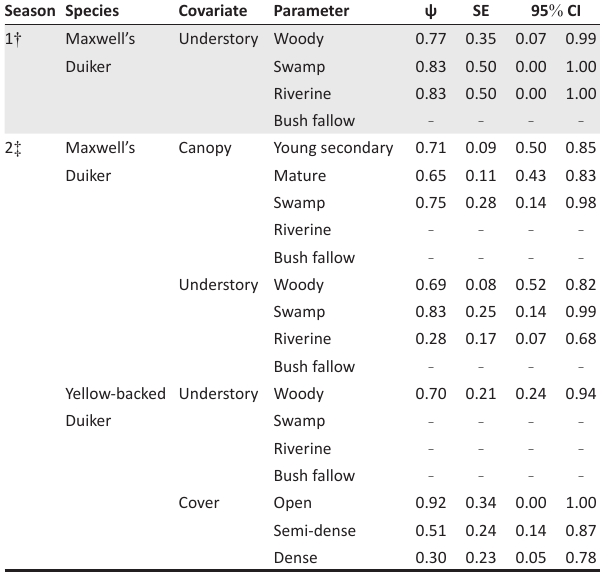
TABLE 3: Duiker occupancy of specific Tiwai Island habitat parameters for best- fitting models (Δ AIC < 4) used in analysis.